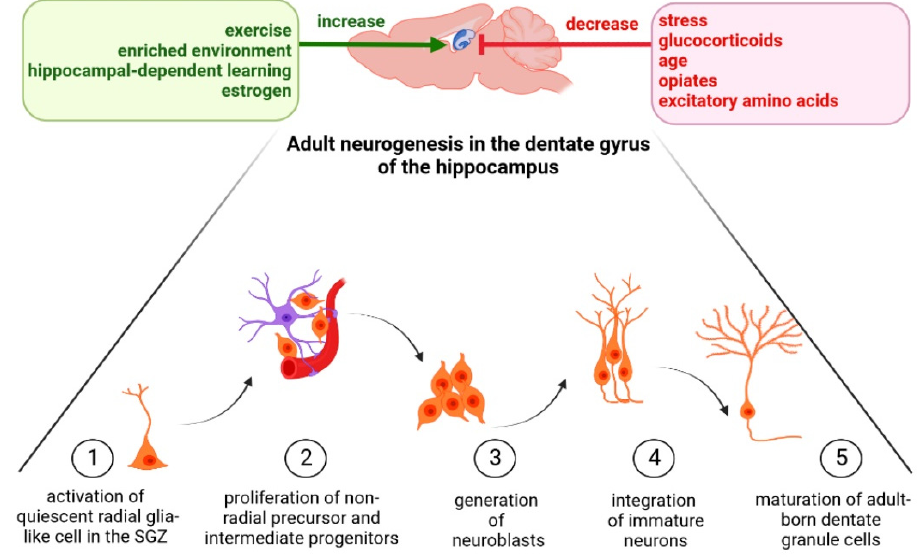
Figure 1. Changes in adult hippocampal neurogenesis by numerous factors ( The figure was made in Biorender ).